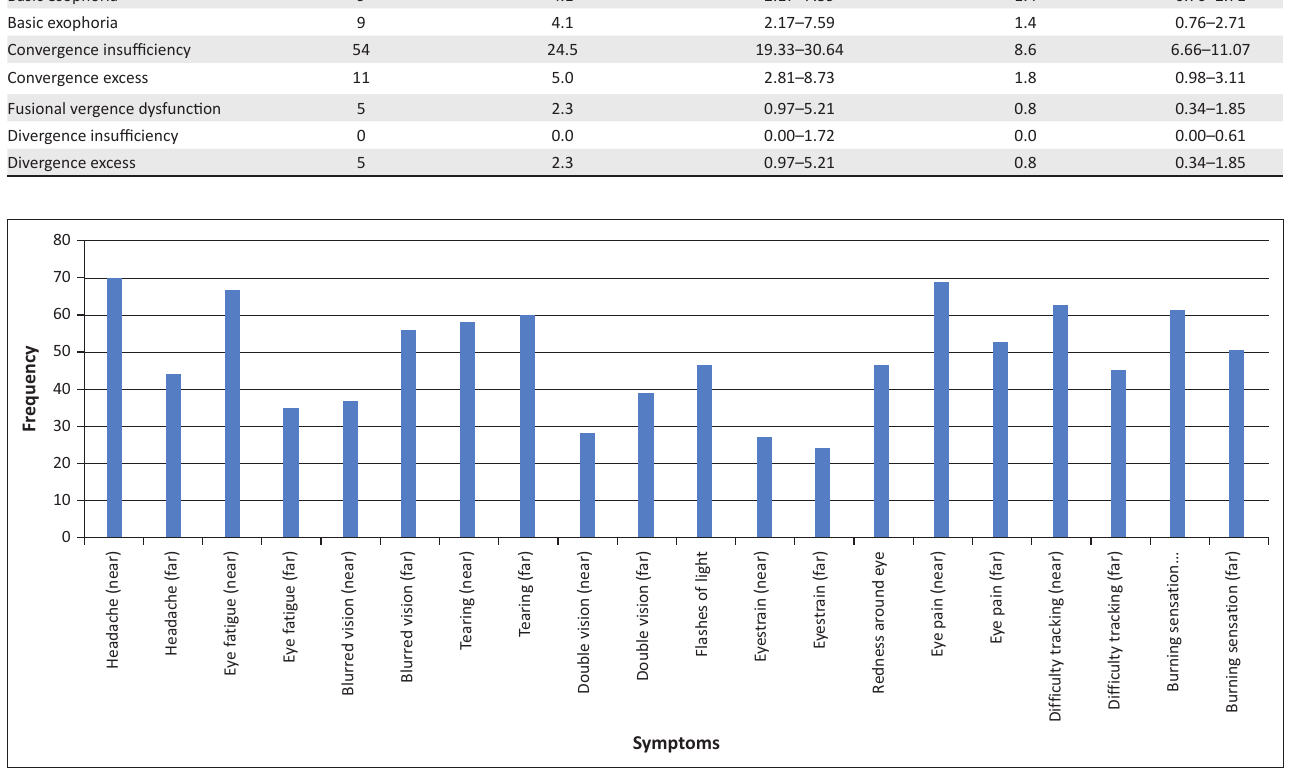
FIGURE 2: Distribution of asthenopic symptoms among junior high school participants with symptomatic vergence